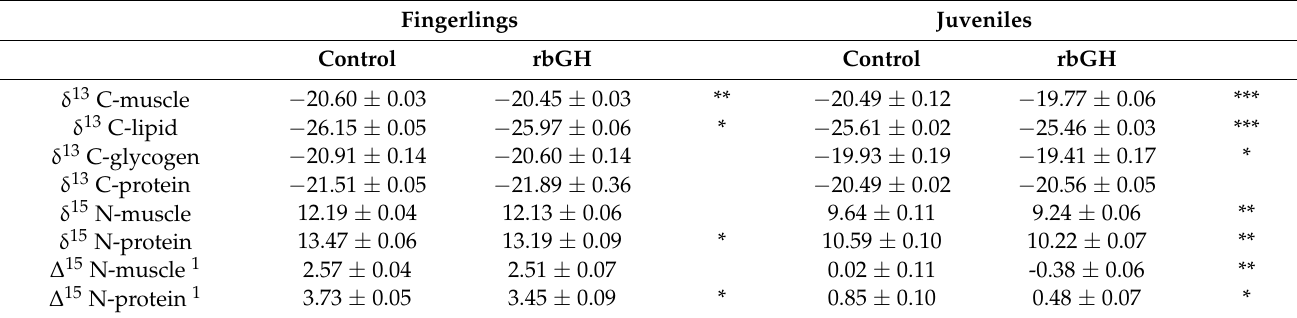
Table 4. Isotopic composition ( 15 N/ 13 C) in white muscle after 6 or 9 weeks of rBGH injection on gilthead sea bream fingerlings and